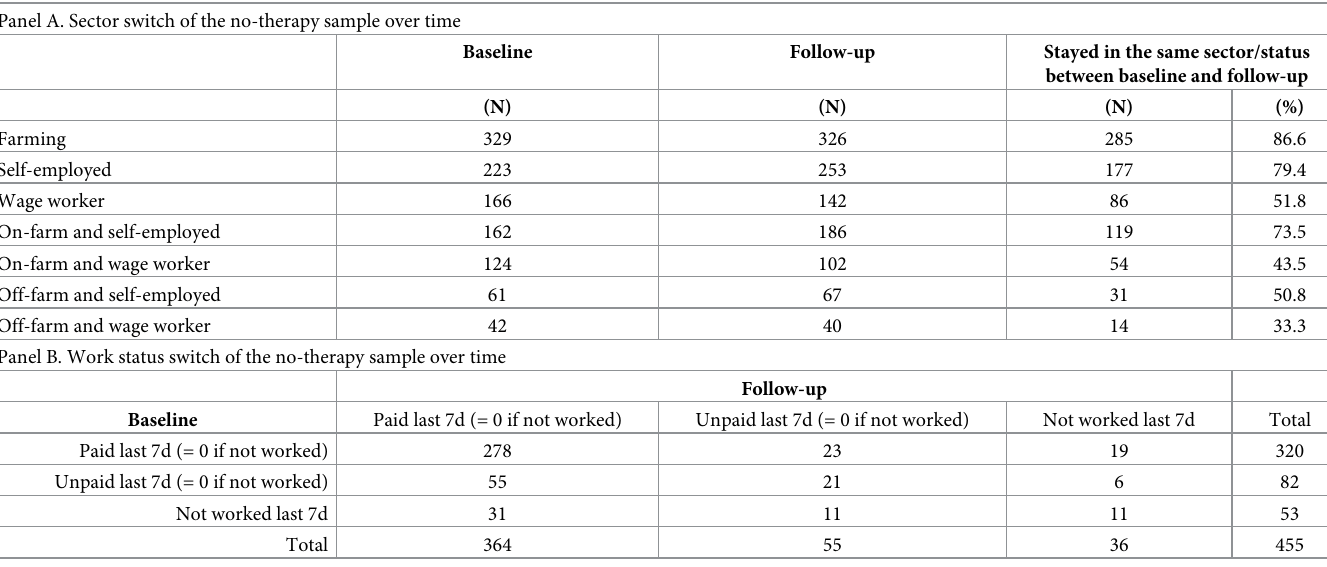
Table 6. Sector and work status switches of the no-therapy sample over time. Panel A. Sector switch of the no-therapy sample over